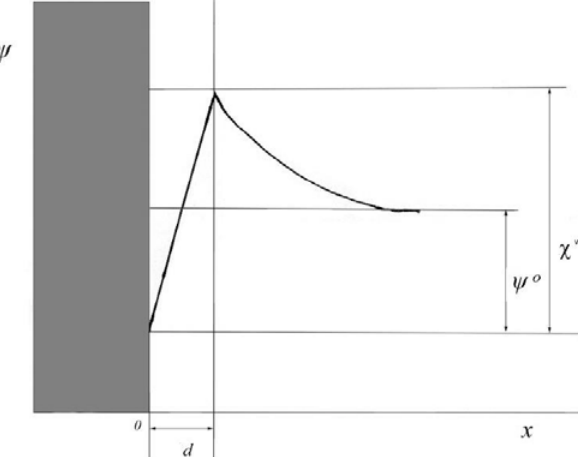
Figure 2. Sketch of the potential jump at a solid-liquid phase boundary as caused by the χ-potential. Modified after ref. 1, their figure 1. Discussion in the